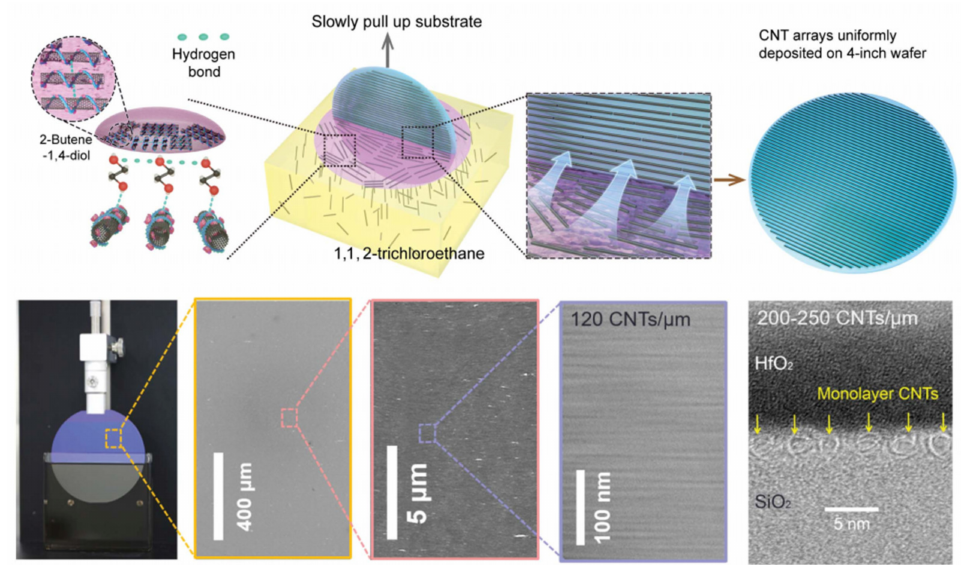
Figure 2. Alignment of CNT films produced by dip coating, reproduced with permission from [42]. Copyright the authors